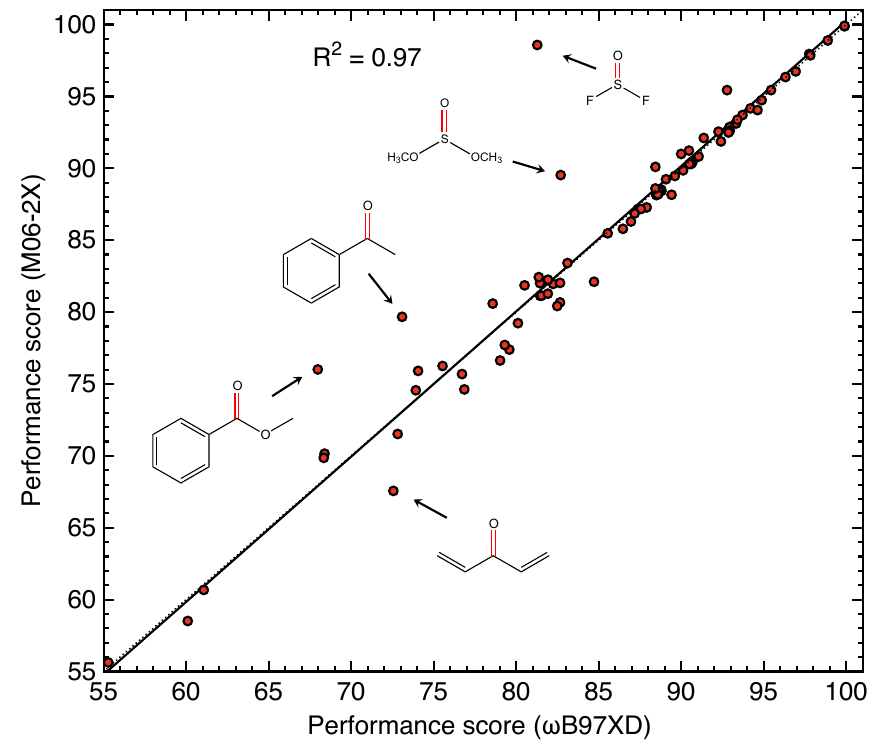
Figure 8. Correlation in the performance scores calculated with M06-2X and ω B97XD for probe molecules studied in this work. The solid line shows a linear correlation with R 2 = 0.97, and the dashed line shows the line of y = x